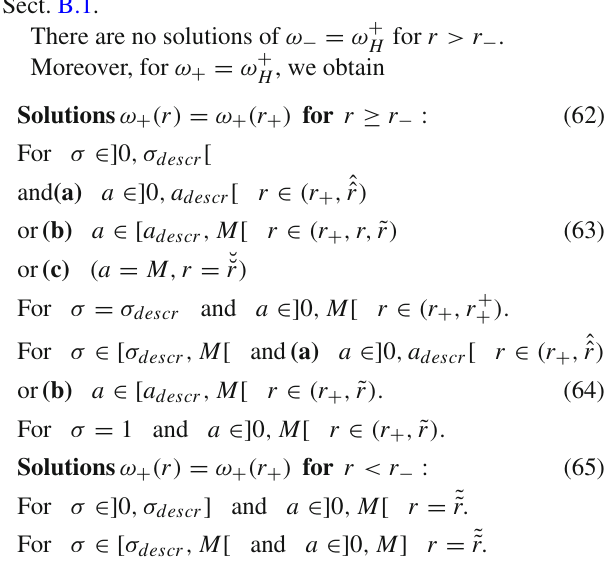
Fig. 19 Photon orbital frequencies as horizons frequencies. Solutions of ω − = ω − ( r − ) for a ∈ [ 0 , M ] , and of ω + = ω + ( r − ) for a ∈ [− M , 0 ] for r > r − –Eqs (60) and (54). Left panel: a descr / M as function of σ ≡ sin 2 θ . Center panel: solutions ω − = ω − ( r − ) on the plane ( r / M , a / M ) for different planes σ ∈ [ 0 , 1 ] ; a zoom for a ≈ M is